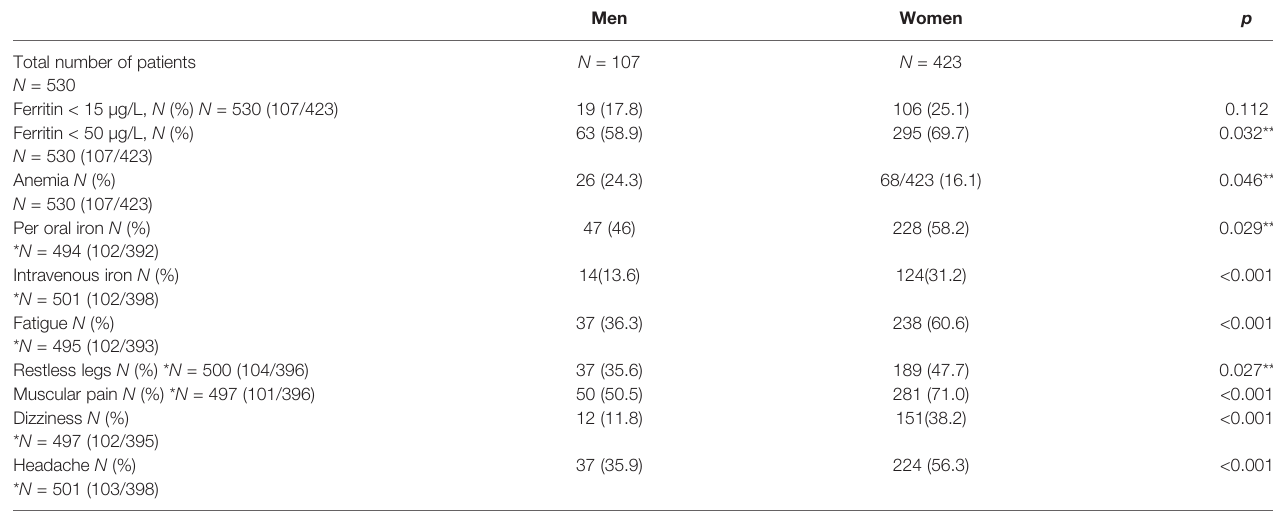
TABLE 2 | Frequency of iron de fi ciency, anemia, iron supplements, and related symptoms in men and women 10 – 15 years after RYGB-surgery.